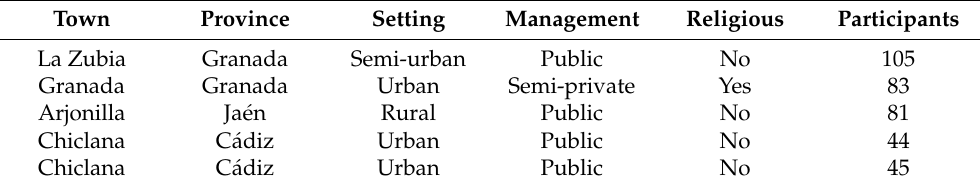
Table 1. Schools in which the sample is taken.